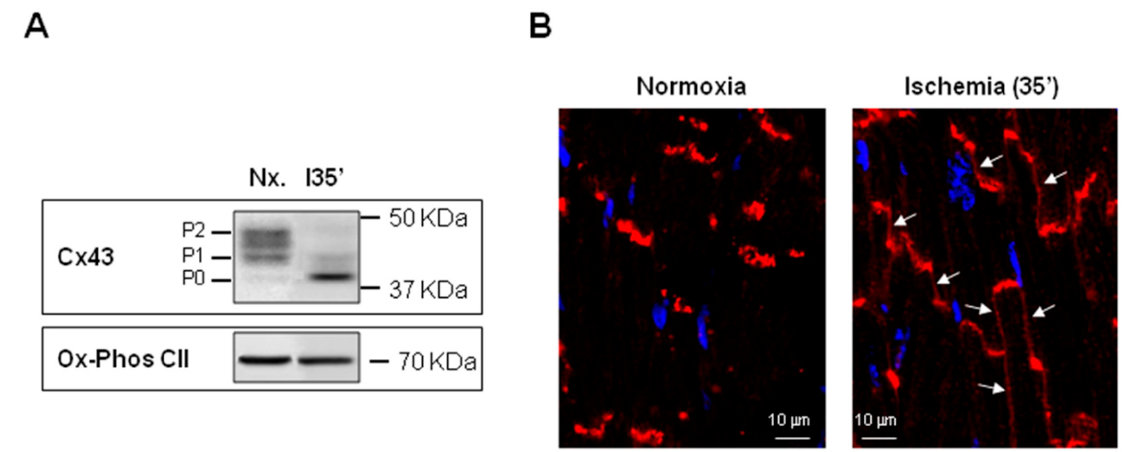
Figure 5. ( A ) Western blot showing expression of Cx43 in isolated mice hearts submitted to normoxic perfusion or to 35 min of global ischemia. Mitochondrial respiratory complex II was used as loading control. ( B ) Distribution of Cx43 in cardiac slices obtained from isolated mice hearts submitted to the same protocols. Arrows indicate lateralized gap junctions appearing under ischemic conditions.